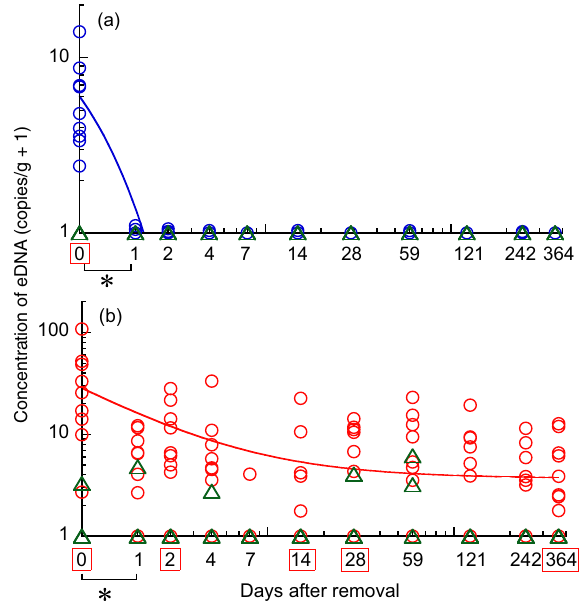
Figure 4. Concentration of eDNA in ( a ) tank water and ( b ) sediment after the removal of fish. Circles and triangles represent test and control tanks, respectively. Asterisks indicate significant differences between two consecutive sampling days, and squares indicate significant differences between test and control tanks on the same sampling day ( p < 0.05, ANOVA). The best models in Supplementary Table S3 were